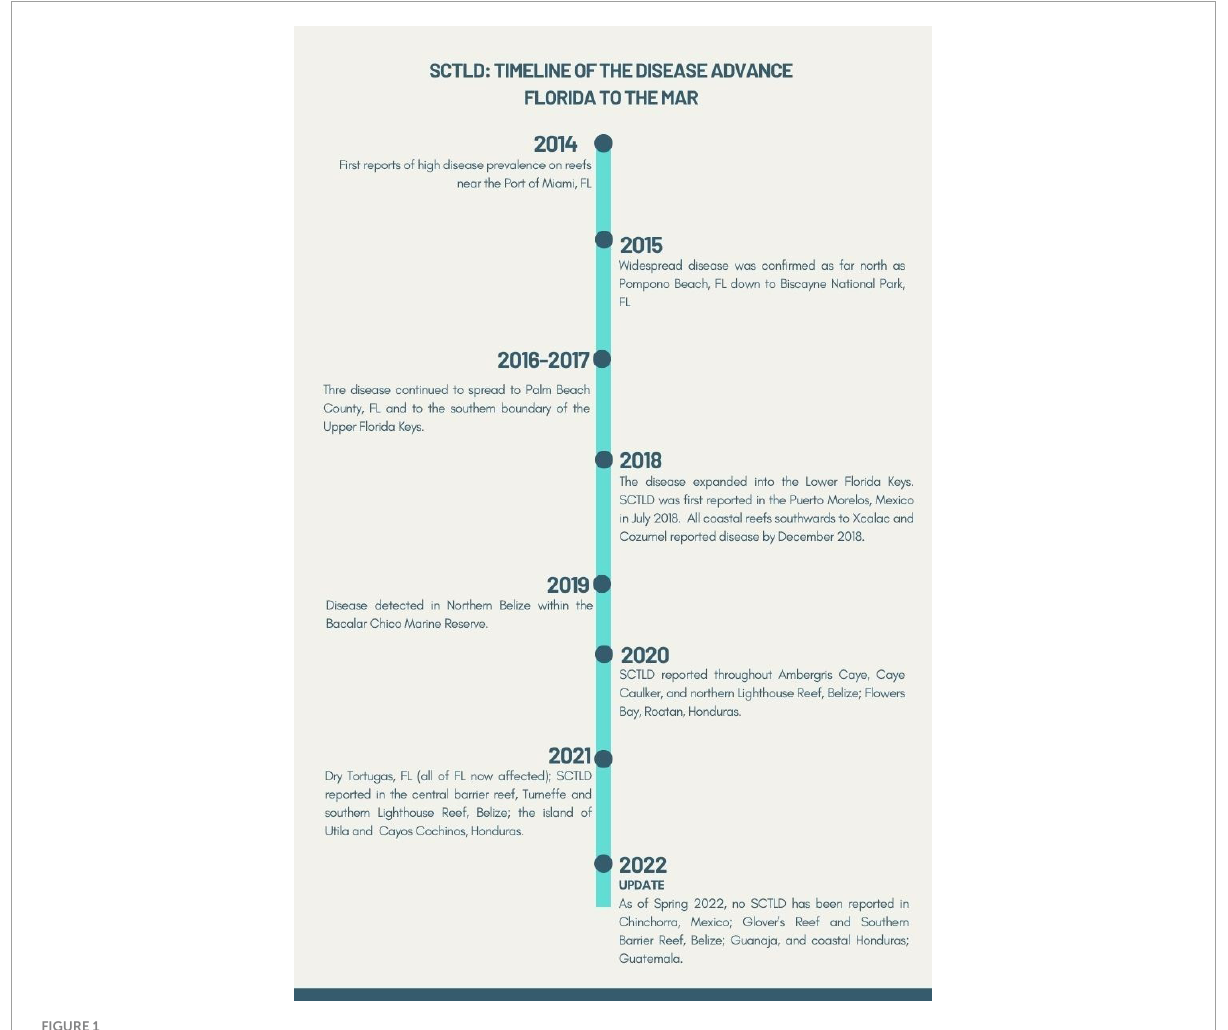
FIGURE 1 SCTLD outbreak timeline in Florida and the Mesoamerican